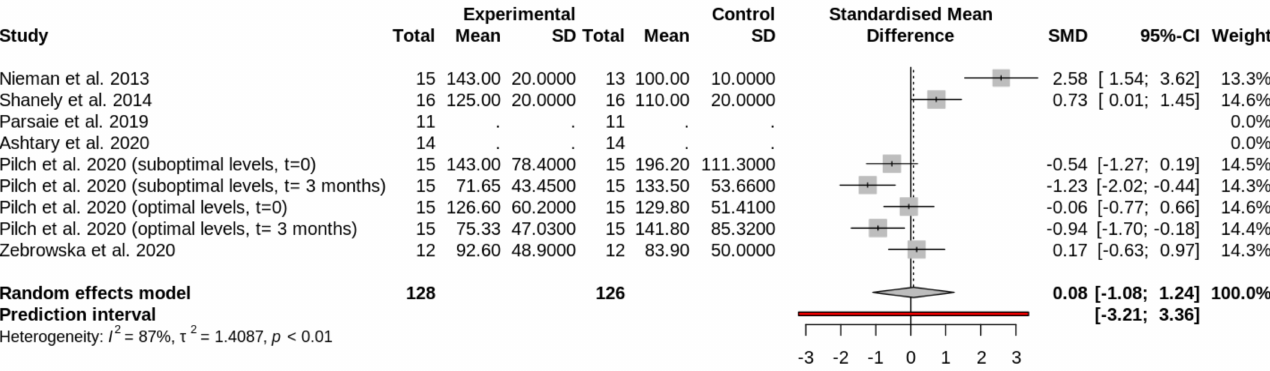
Figure 4. Forest plot comparing the effects of vitamin D supplementation on circulating Mb levels after exercise. The squares in the forest plot on the left side of the line represent studies or groups in which the mean of the experimental group (supplemented) was lower than the mean of the control group (placebo). The ones in the right side indicate the